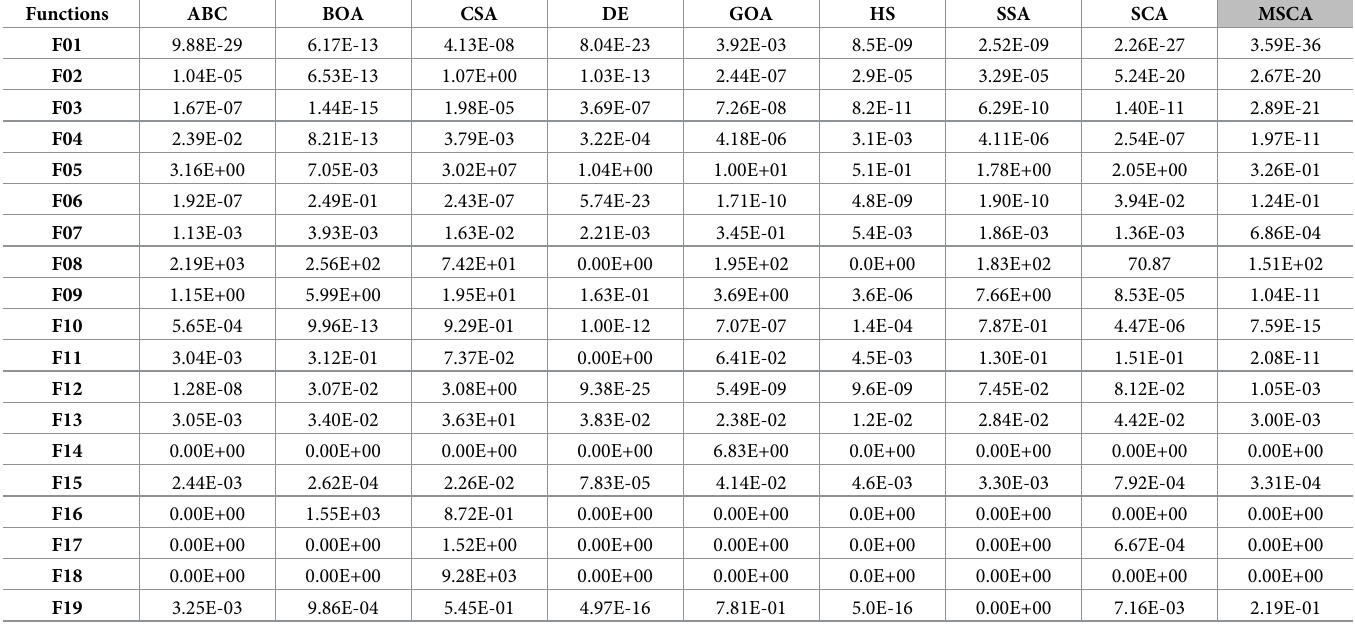
Table 5. Standard deviation (SD) of algorithms on benchmark